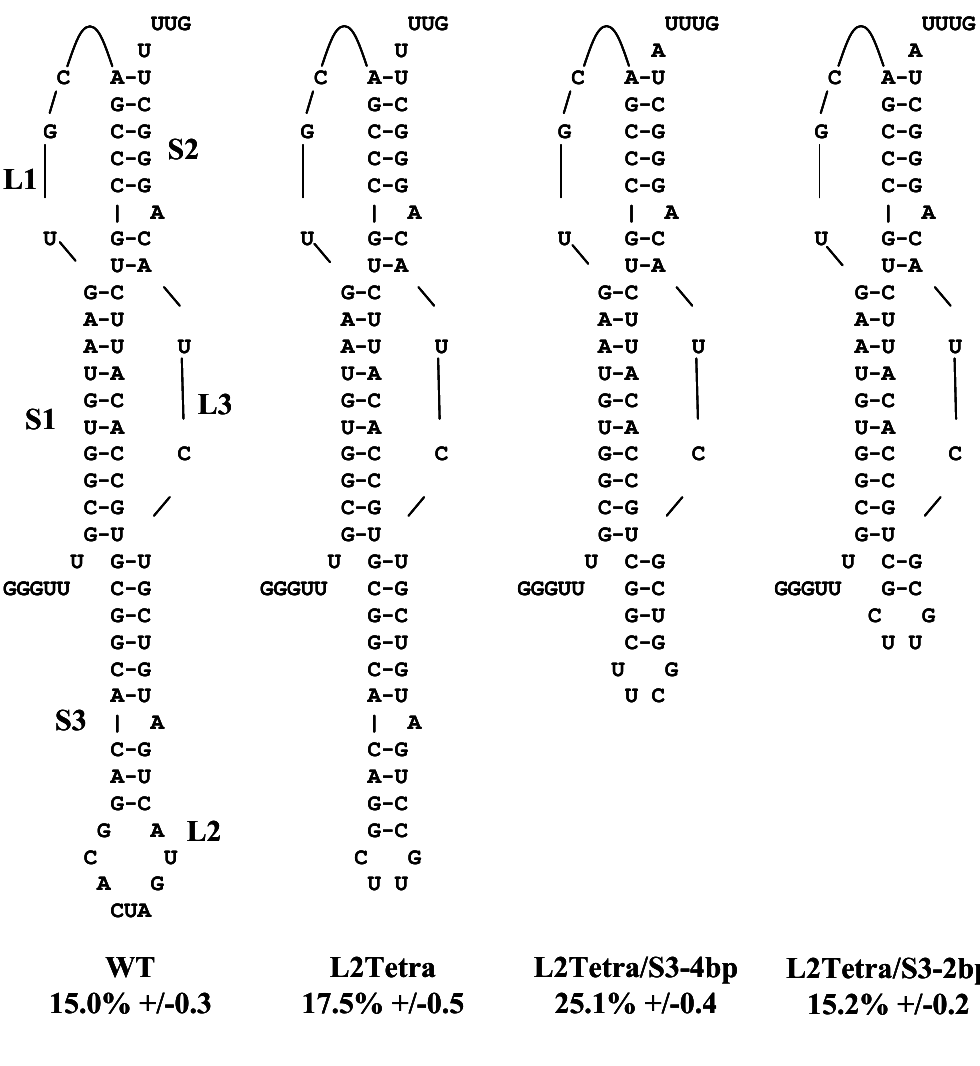
Figure 1. Removing stem 3 does not reduce programmed -1 ribosomal frameshifting (-1 PRF) efficiency. The predicted secondary structure of the SARS coronavirus pseudoknot is shown, along with a series of mutants with stem 3 truncated. The stems are labeled S1 to S3 and the loops labeled L1 to L3. Site directed mutagenesis was used to replace the wild-type loop 2 with a CUUG tetraloop (L2Tetra). Additional truncations to stem3 were made (L2Tetra/S3-4bp and L2Tetra/S3-2bp) and frameshifting efficiency analyzed by dual luciferase assay. Frameshifting efficiency is expressed as a percentage with standard error as described in the experimental